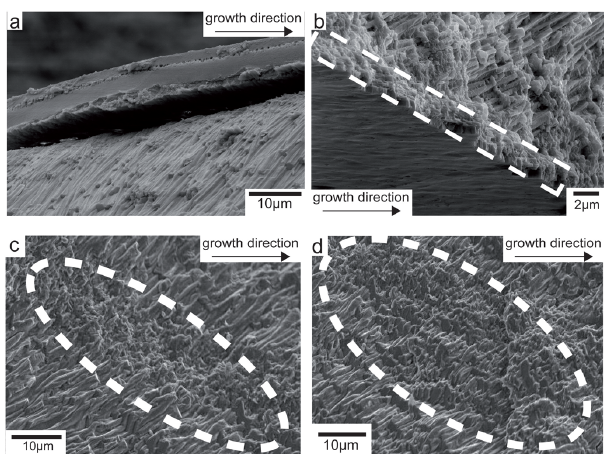
Fig. 3. Calcite layer SEM images from Mytilus galloprovin- cialis B1 and C fragments of the surface. Images are from outer mar- gin precipitated from normal marine seawater pH (a, b) and from shells precipitated from acidified seawater (c, d) . ( a and b ) Calcite layer of M. galloprovincialis from control site C (pH T =8.07). Note well structured calcite layer. White stippled box indicates aragonite layer. ( c and d ) Calcite layer of M. galloprovincialis from acidi- fied experimental site B1. Note portions of calcite layer with disor- ganized shell structure (white stippled oval) within otherwise well organized calcite